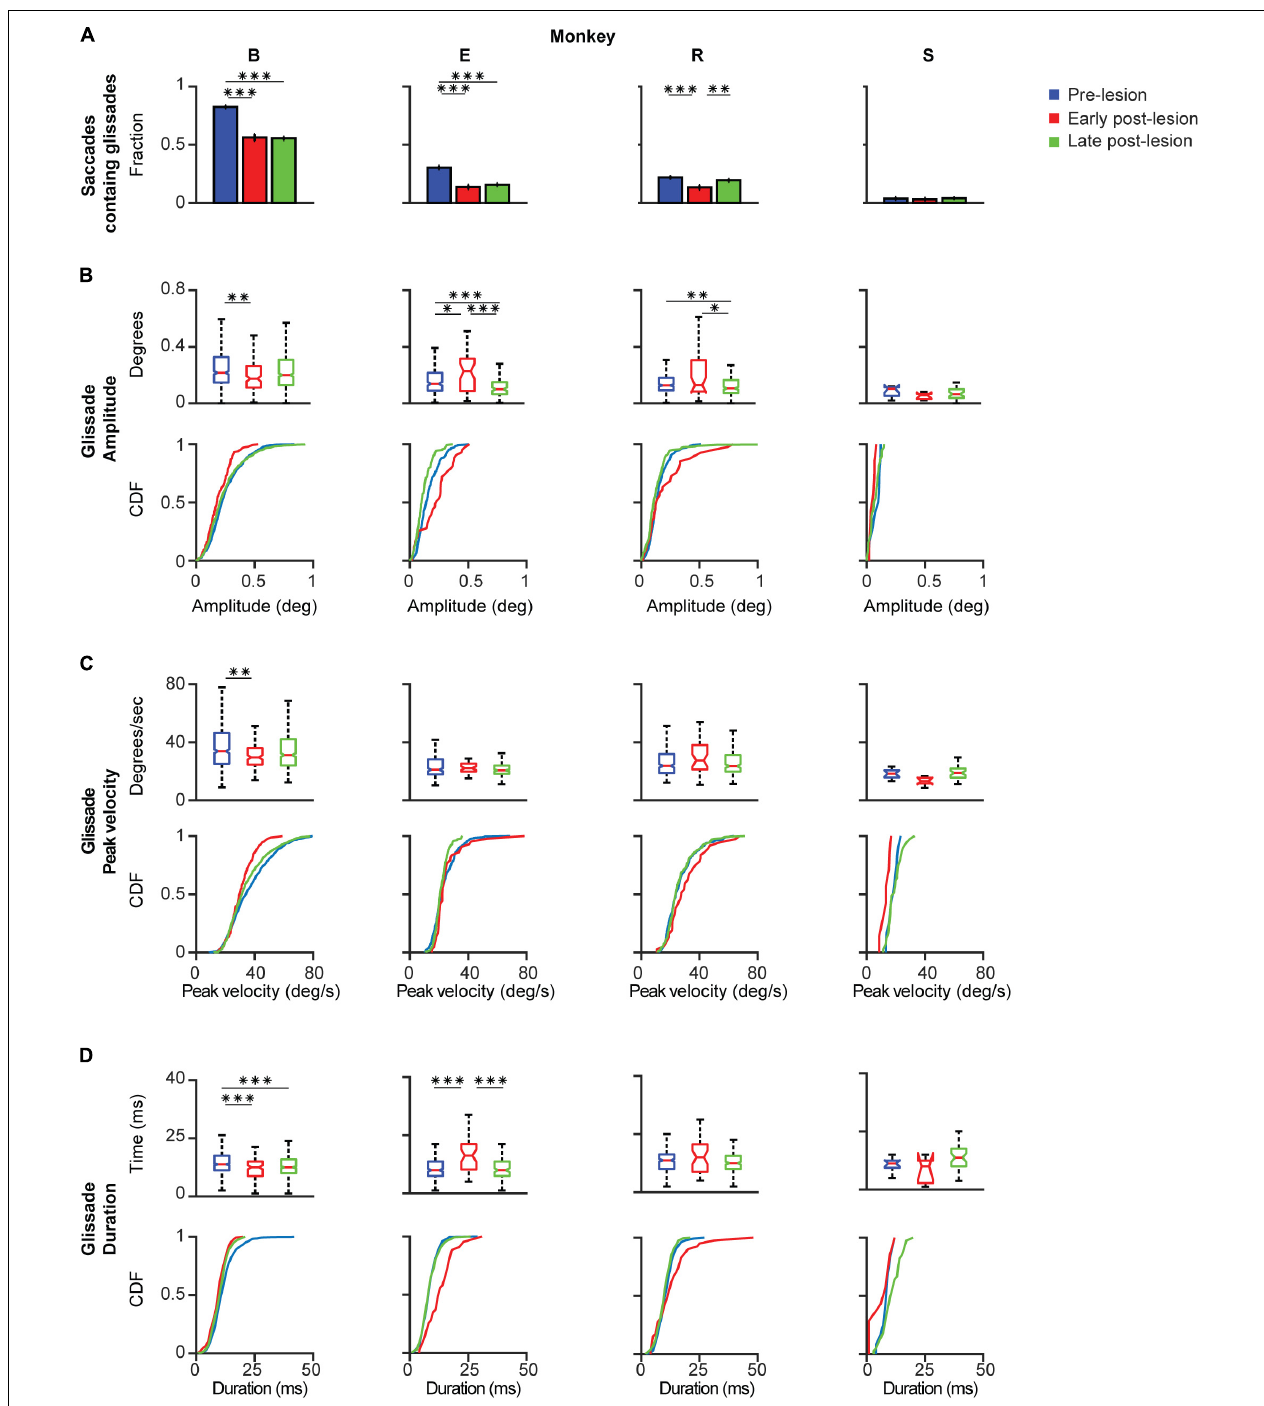
FIGURE 6 | Post-lesion changes to glissadic overshoots. Glissade kinematics were sorted in a pre-, early, and late post-lesion groups. Early post-lesions was defined as the day of the lesion + 3 half-lives of the exponential fit in Figure 5 , everything thereafter was classified as late post-lesion (for more details see section Results). Number of days that were classified as early post-lesion period is shown in the bottom row of Supplementary Table 3 . (A) Fractions of saccades with a glissade for individual monkeys. Error bars represent Jeffrey’s interval for proportions. (B) Box plots and [Cumulative Distribution Function (CDF)] of glissade amplitudes for individual monkeys. Boxes edges indicate 25th and 75th percentile, box midline indicate the median. Whiskers extend to the most extreme data points not considered outliers. (C) Box plots and CDF of glissade velocities. (D) Box plots and CDF of glissade durations. Only overshooting glissades were used for this analysis. See Supplementary Table 4 for p -values. Labels “B,” “E,” “R,” and “S” denote each of the four monkeys. ‘ ∗ ’ symbols denote p -values of < 0.05; ‘ ∗∗ ’ symbols denote p -values of < 0.01; ‘ ∗∗∗ ’ symbols denote p -values of < 0.001.